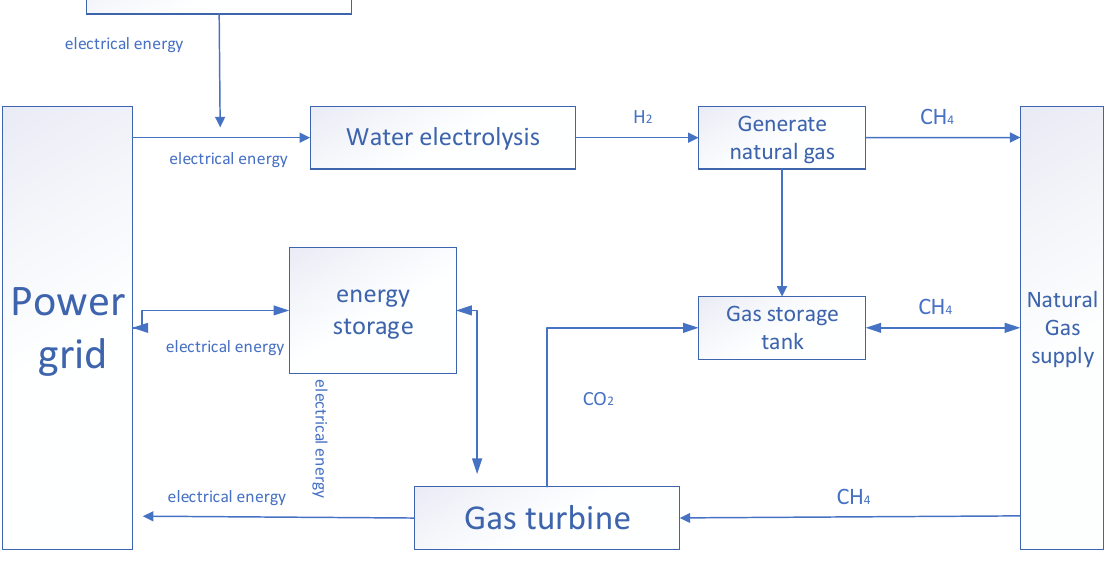
Figure 1. Framework of the regional gas–electric integrated energy system .